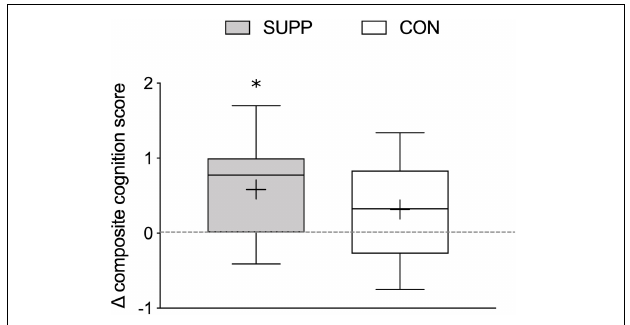
FIGURE 6 | Change in composite cognitive function scores between baseline and 19 weeks. Composite cognitive function scores were calculated using MOCA scores, delayed recall (Trial 7) performance on the RAVLT, and reaction time during correct “Go” trials during the Go-NoGo Task. Boxes (SUPP: gray; CON: white) represent interquartile (25th to 75th percentile) ranges, with the horizontal lines indicating the median. Whiskers represent the maximal and minimal values, and the cross indicates the mean. ∗ indicates a significant difference from no change (i.e., zero). SUPP, supplement; CON, control.